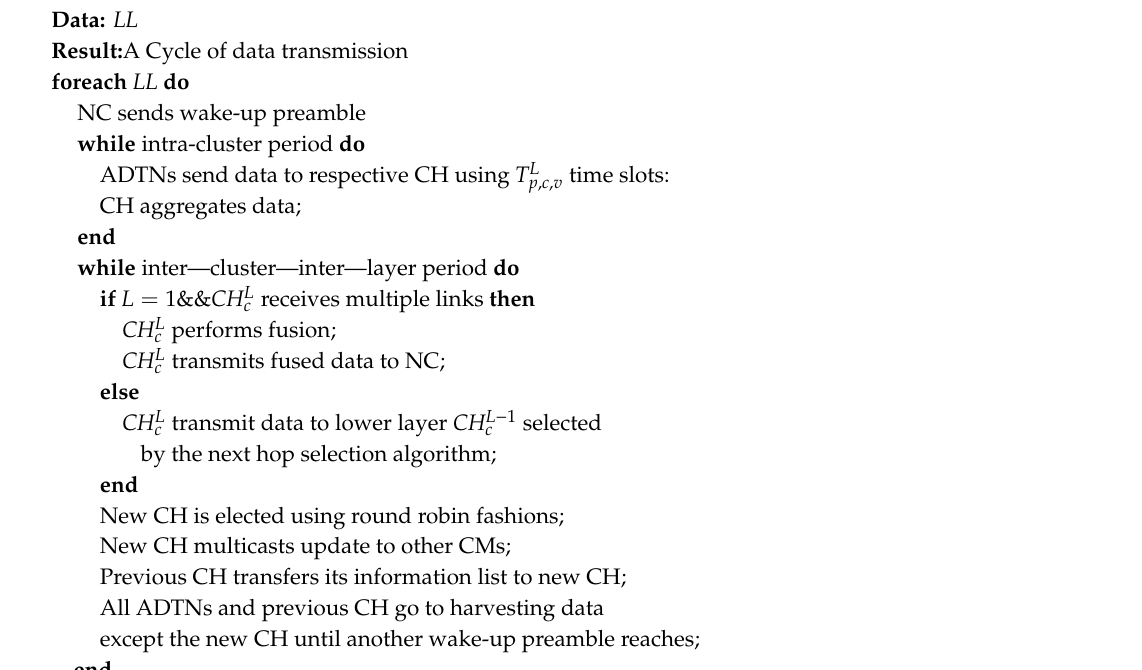
Algorithm 4: DTP (Data Transmission Process)